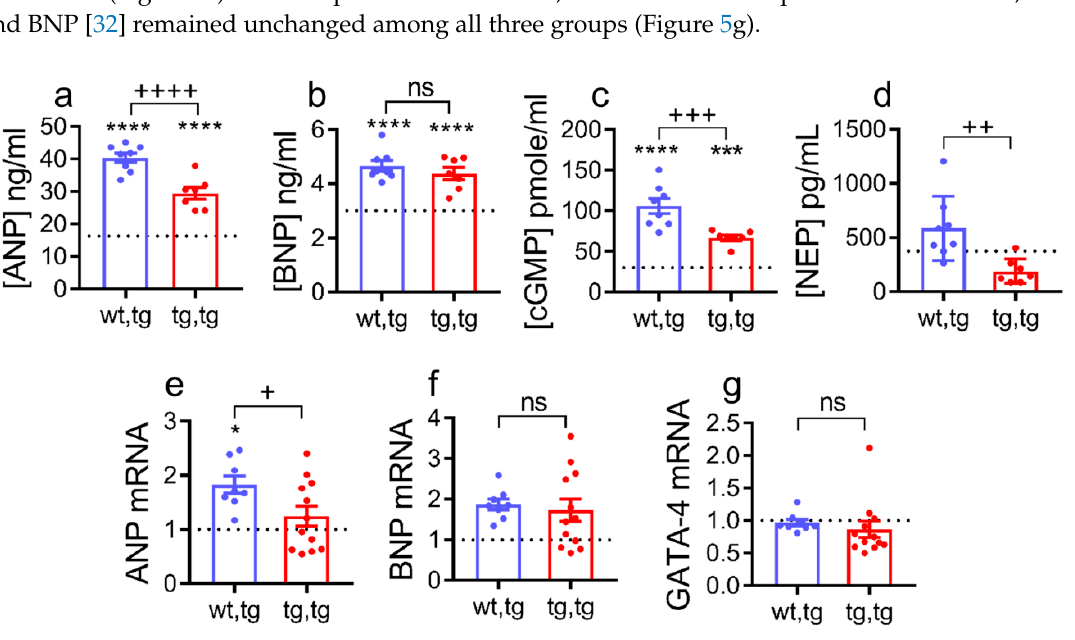
Figure 5. Effect of cardiac corin-Tg(i) overexpression on the natriuretic peptide system plasma biomarkers and cardiac expression levels in female mice with DCM. Plasma levels of ( a ) atrial natriuretic peptide (ANP), ( b ) b-type natriuretic peptide (BNP), ( c ) cyclic guanosine monophosphate (cGMP), and ( d ) neprilysin (NEP), determined by ELISA, n = 7–8 per group. Cardiac transcript levels of ( e ) pro-ANP, ( f ) pro-BNP, and ( g ) GATA-4, determined by qRT-PCR, n = 8–12 per group. Dotted line represents WT levels (wt,wt; n = 6–7). Differences were analyzed by one-way-ANOVA using Newman–Keuls multiple comparison test for ( a – f ), and for ( g ), by Kruskal–Wallis test using Dunn’s multiple comparison test. Experimental groups were mice at 90 days of age: Corin-Tg(i)/DCM ( ● , tg,tg) and corin-WT/DCM ( ● , wt,tg) mice. Data are represented as mean ± SE; **** p < 0.0001, *** p < 0.001, * p < 0.05 (tg,tg or wt,tg vs. wt,wt); ++++ p < 0.0001, +++ p < 0.001, ++ p < 0.01, + p < 0.05 (tg,tg vs. wt,tg),